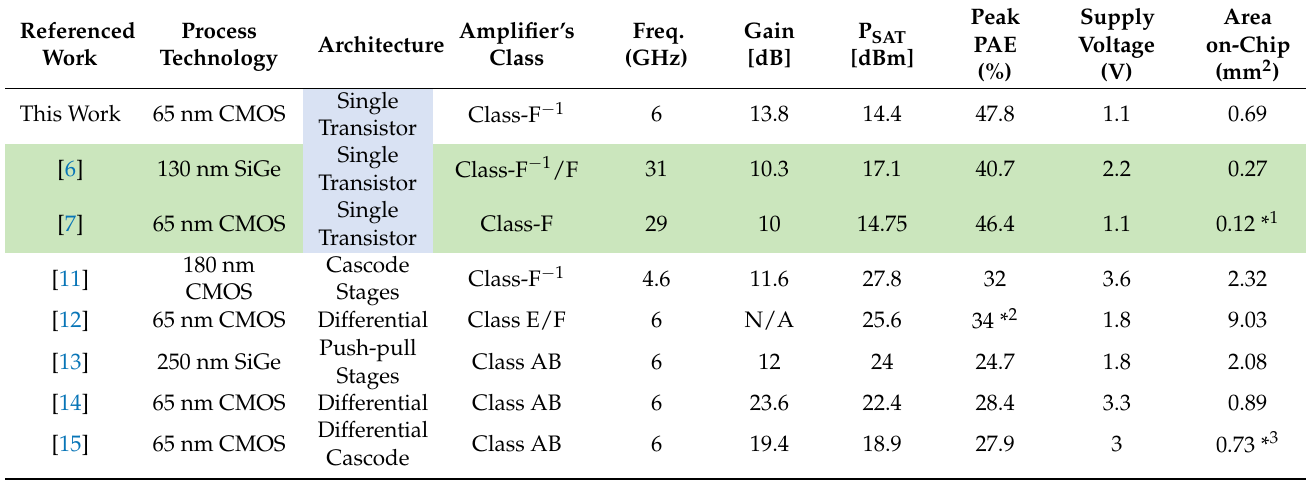
Table 2. Comparison of recently reported CMOS and SiGe-BiCMOS